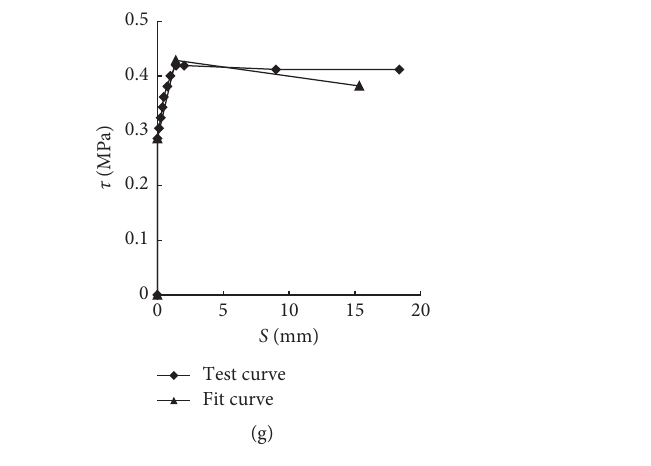
Figure 12: Fit curves and test curves of τ –S: (a) specimen C-2, (b) specimen C-3, (c) specimen C-5, (d) specimen C-6, (e) specimen C-7, (f) specimen C-8, and (g) specimen